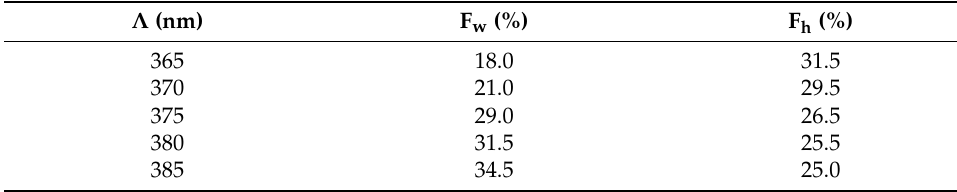
Table 4. The grating parameters of Figure